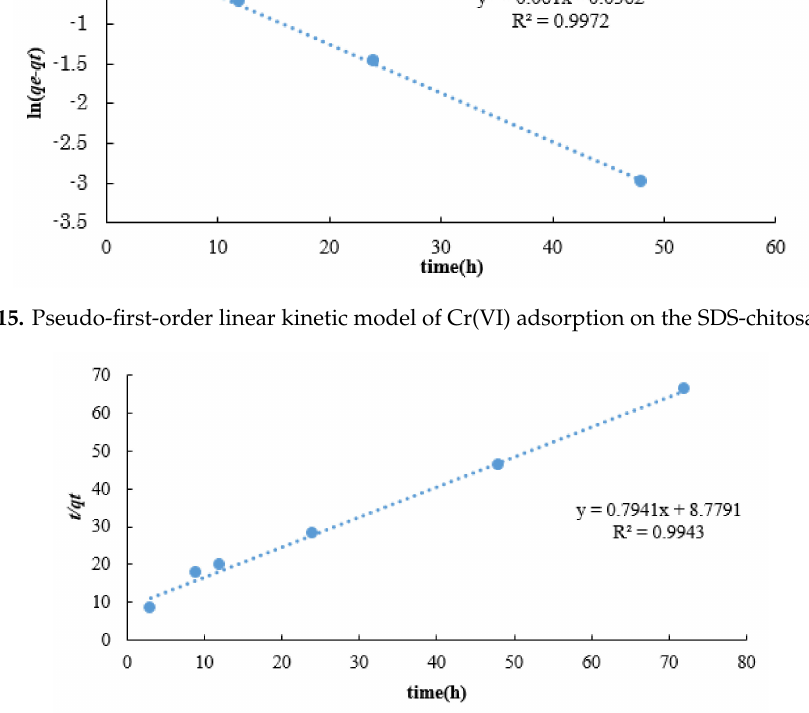
Figure 16. Pseudo-second-order linear kinetic model of Cr(VI) adsorption on the SDS-chitosan beads. Table 5. Kinetic parameters of Cr(VI) adsorption onto the SDS-chitosan beads.